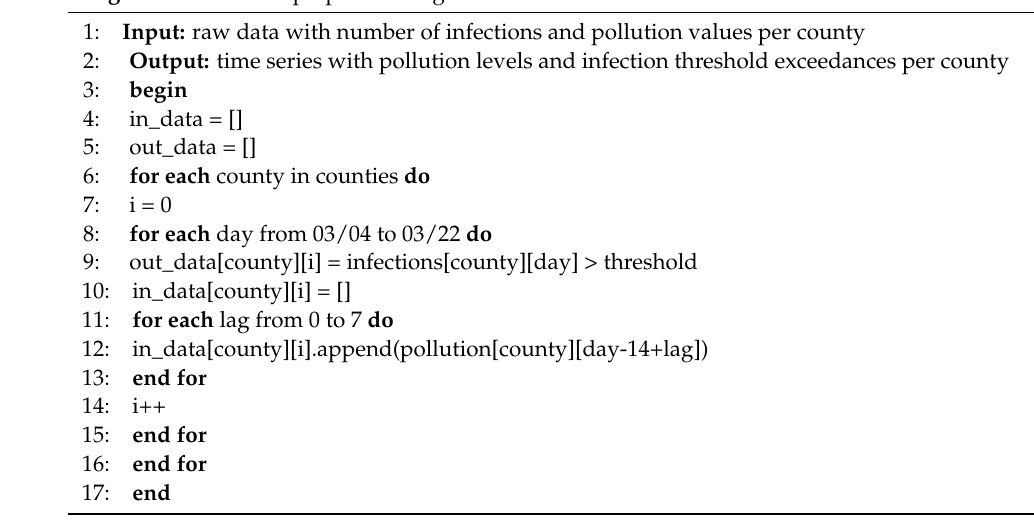
Algorithm 1 Dataset preparation algorithm.